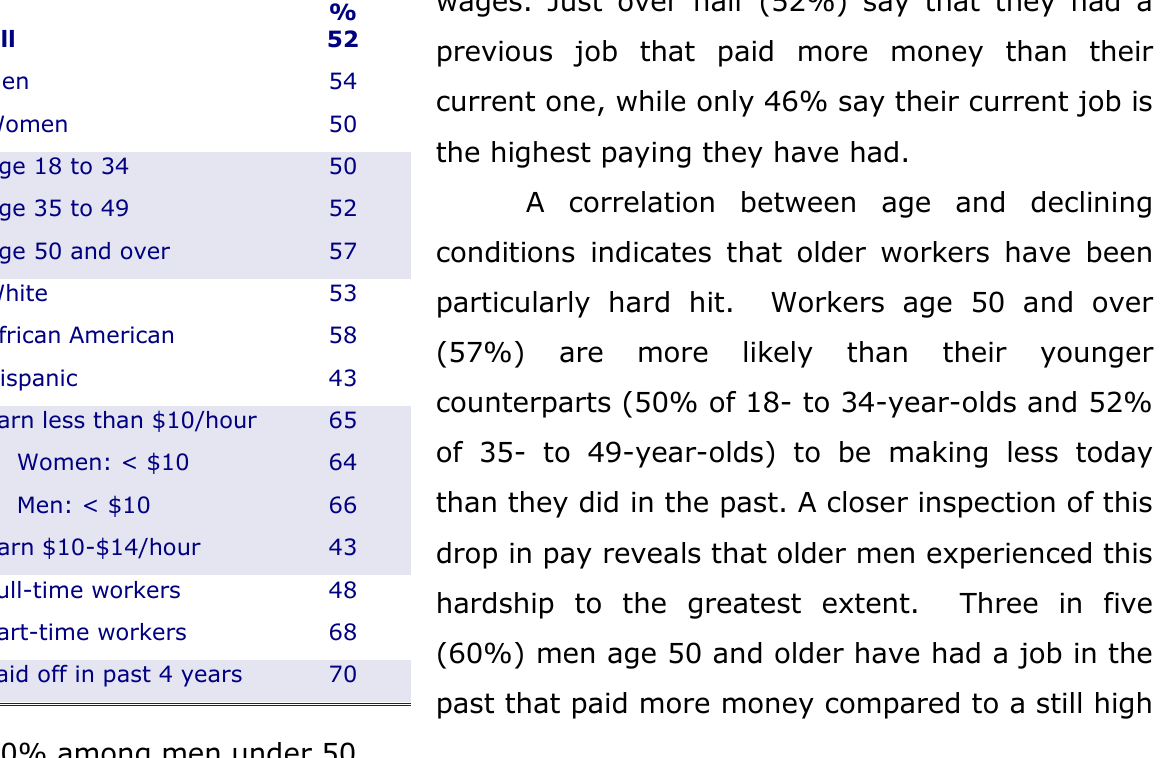
Table 5: Making Less Than in The Past